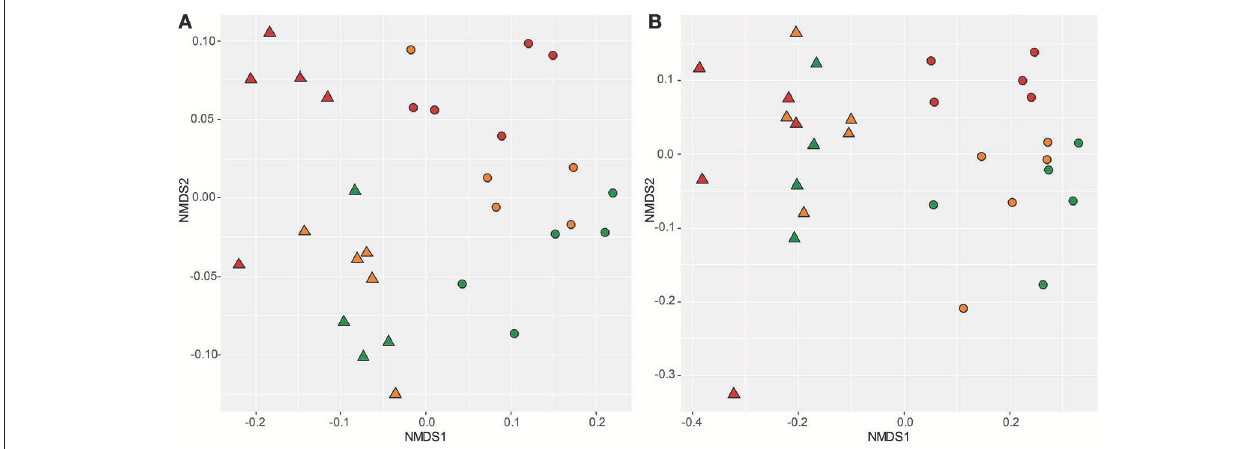
FIGURE 2 | Influence of Cd and the plant rhizosphere on bacterial community structure. Non-metric multidimensional scaling ordination of bacterial communities using weighted (A) and unweighted (B) UniFrac distance. Ordination stress values are 0.10 and 0.12, respectively. “ ◦ ” indicate bulk-soil community samples, “ 1 ” indicate rhizosphere community samples. Color is indicative of Cd treatment: Green = 0mg Cd kg − 1 soil; Amber = 20mg Cd kg − 1 soil; Red = 100mg Cd kg − 1 soil.